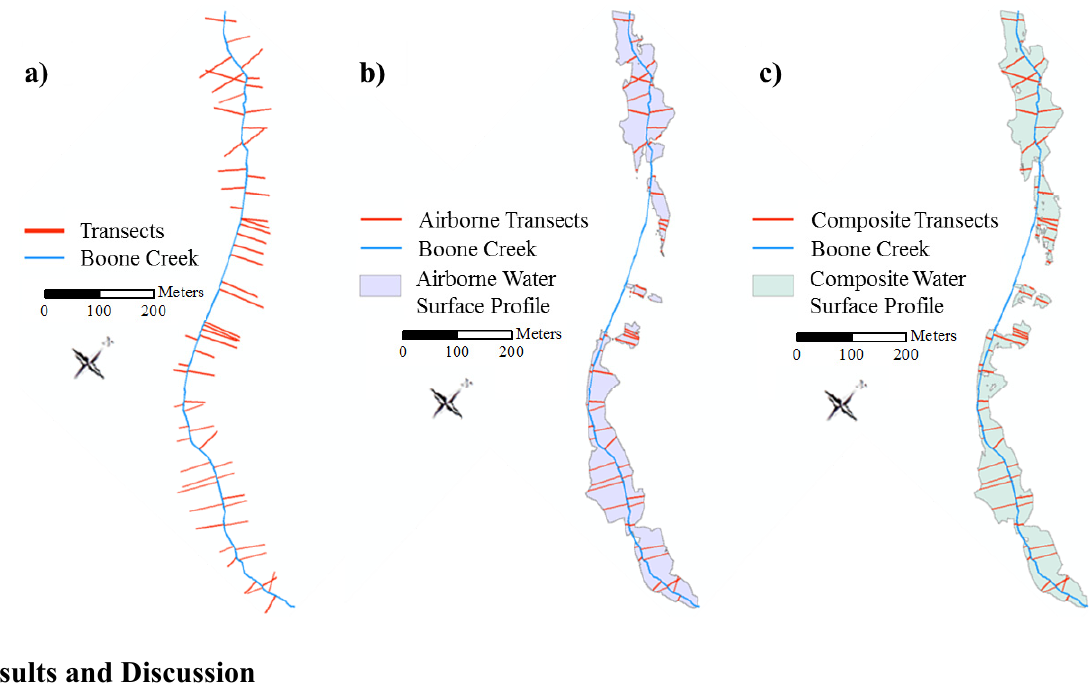
Figure 7. Randomly stratified transect lines drawn perpendicular to the study stream for use in a flood modeling diagnostic. The intersection of the water surface profiles and the transect lines were computed in ArcGIS and the distance flooded along each transect was calculated. ( a ) Original transect lines; ( b ) Transects clipped to the intersection of the airborne LiDAR-derived water surface profile; ( c ) Transects clipped to the intersection of the composite LiDAR-derived water surface